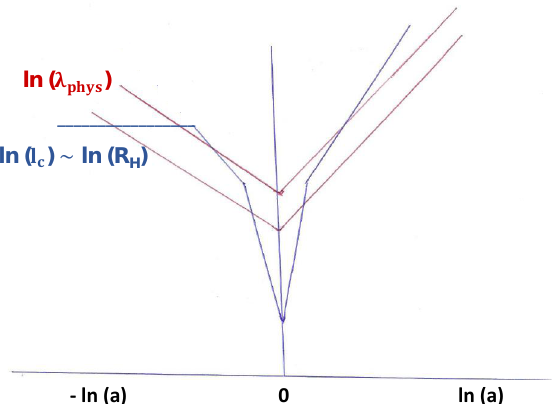
Figure 4. Qualitative comparison between evolution of the curvature scale, in blue, and cosmological scales, in red, in bouncing models with a cosmological constant. During classical evolution, the curvature scale coincides with the Hubble radius. The scale factor at the bounce is normalized to one; hence, the origin corresponds to the bounce, where the scale factor attains its minimal value. The negative and positive horizontal axis correspond to the contracting and expanding phases, respectively. In the plot, the transitions from dust to radiation domination and dust to cosmological constant domination, and the bounce itself, are qualitatively depicted by sharp transitions. In reality, they are smooth, but it does not alter the physical conclusions presented in the text.